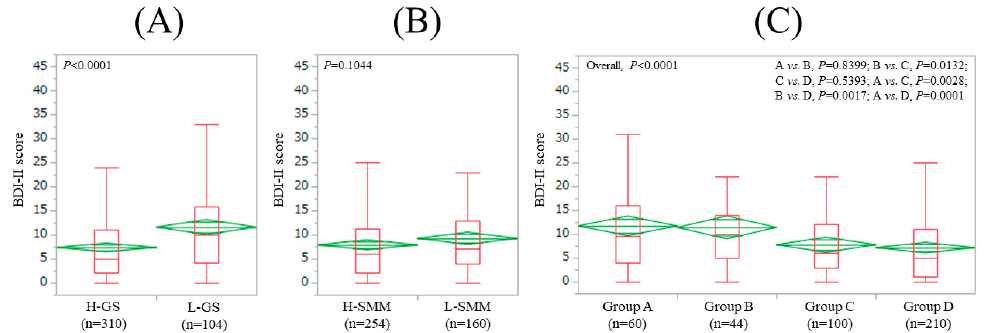
Figure 1. BDI-II score stratified by GS and SMM for all cases ( n = 414). ( A ) Lower GS (L-GS) vs. Higher GS (H-GS). ( B ) Lower SMM (L-SMM) vs. Higher SMM (H-SMM). ( C ) Comparison among four groups (group A, B, C, and D). Group A indicates L-GS and L-SMM. Group B indicates L-GS and H-SMM. Group C indicates H-GS and L-SMM. Group D indicates H-GS and H-SMM. Table 2. Baseline characteristics.